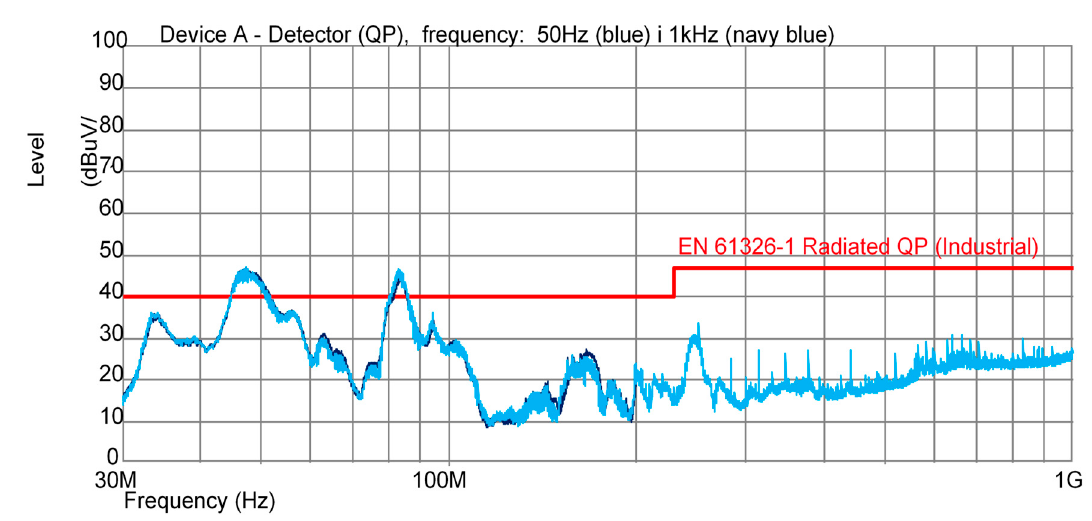
Figure 6. Frequency spectrum of radiated emission of PWM-based power source (device A) for frequencies of generated voltage by the device under test equal to 50 and 1000 Hz.